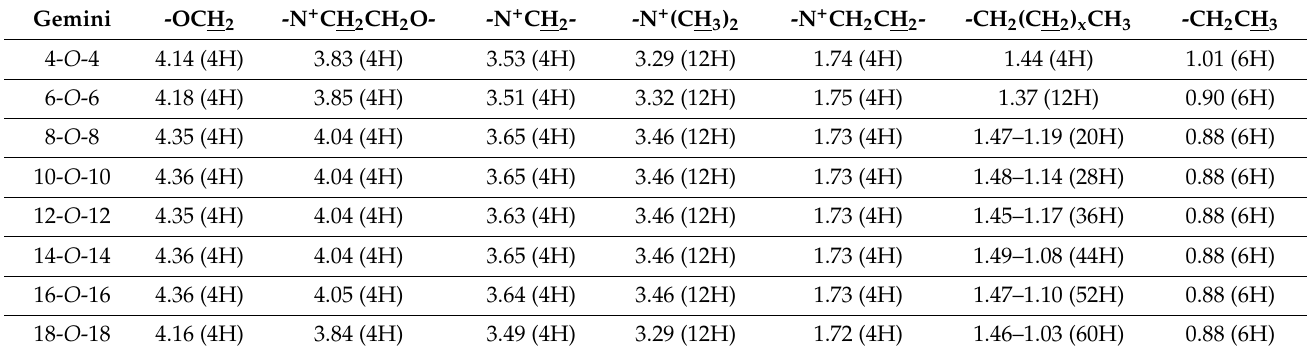
Table 1. Proton chemical shifts from 1 H NMR spectra of gemini surfactants ( n - O - n ) molecules.